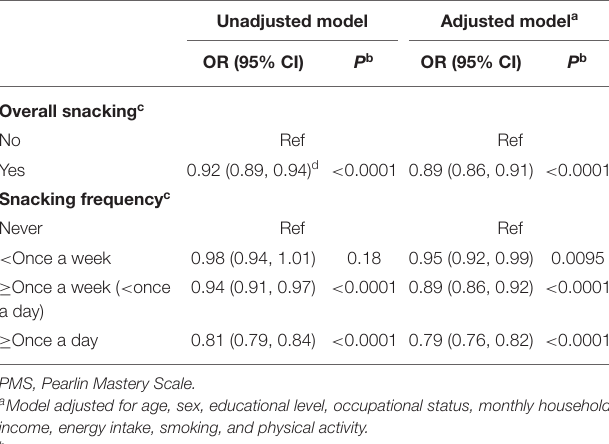
TABLE 5 | Associations between mastery (PMS) and consumption of food groups non-normally distributed (NutriNet-Santé cohort study, 2014). Unadjusted model